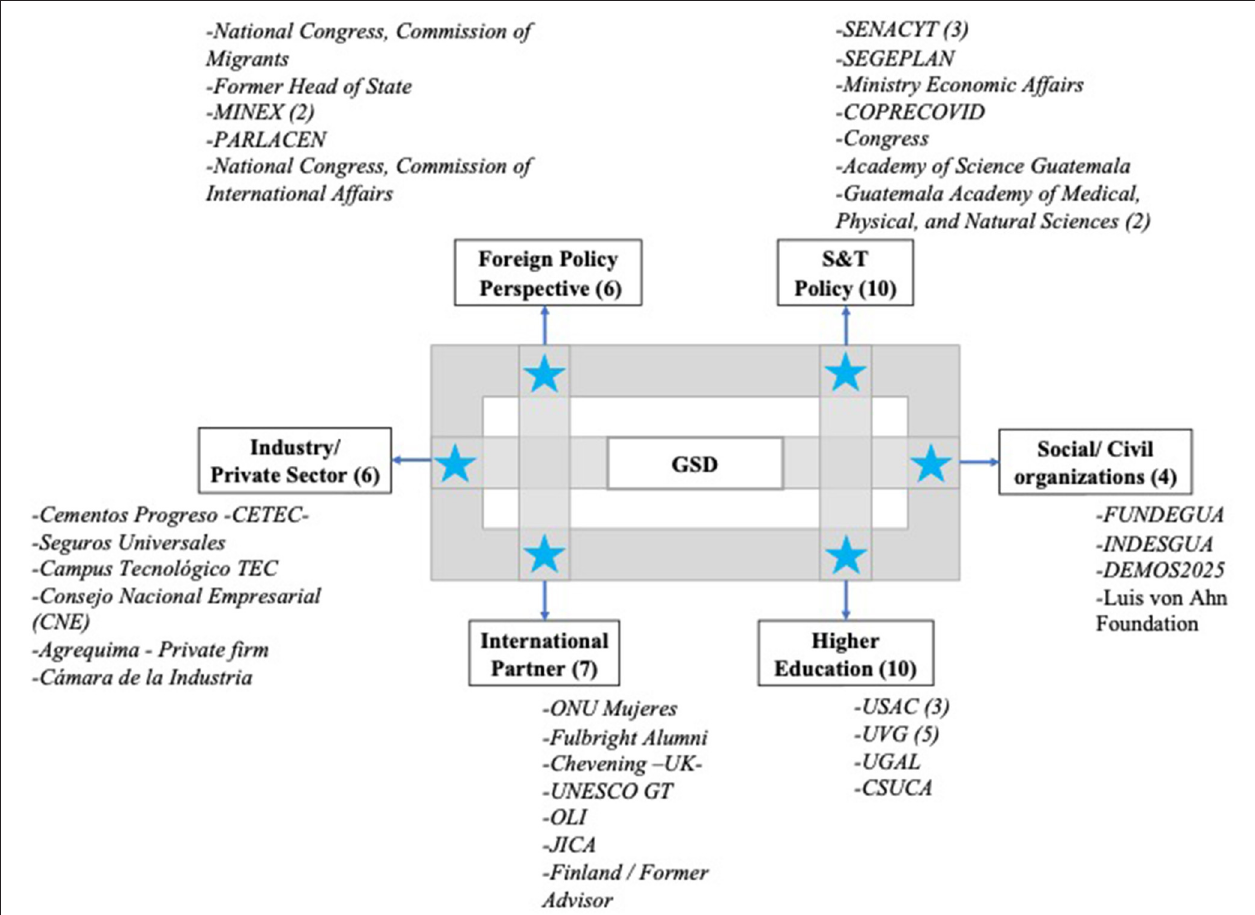
FIGURE 4 | Participant organizations representing the distinct sectoral stakeholders relevant for mapping the GSD (September–February 2022). S&T, Science and Technology; GSD, Guatemalan Scientific Diaspora; MINEX, Ministry of Foreign Affairs; PARLACEN, Central American Parliament; SENACYT, National Secretary of Science and Technology; SEGEPLAN, National Secretariat of Planning; COPRECOVID, National Commission for COVID19; TEC, Technology Campus; OLI, Online Learning Initiative; JICA, Japanese International Cooperation Agency; USAC, University of San Carlos of Guatemala; UVG, University Del Valle; UGAL, University Galileo; CSUCA, Secretary General of the Central American University Council; FUNDEGUA, Guatemala Foundation, INDESGUA, Institute for the Development of Higher Education in